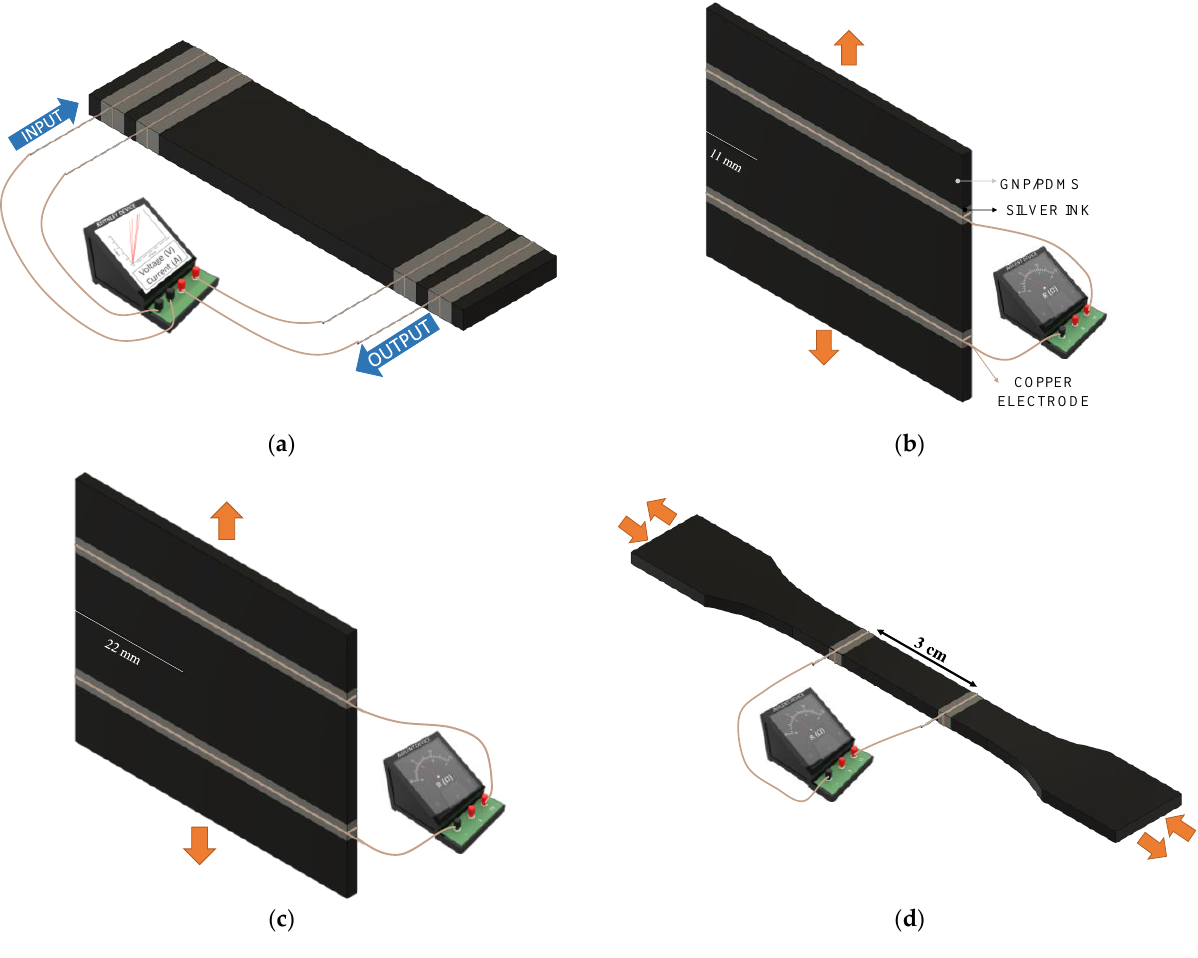
Figure 1. Schematics of samples and electrodes’ disposition in ( a ) electrical conductivity measure- ments, ( b ) crack grown test monitoring (pre-crack of 11 mm), ( c ) crack grown test monitoring (pre- crack of 22 mm), and ( d ) cycling test monitoring.